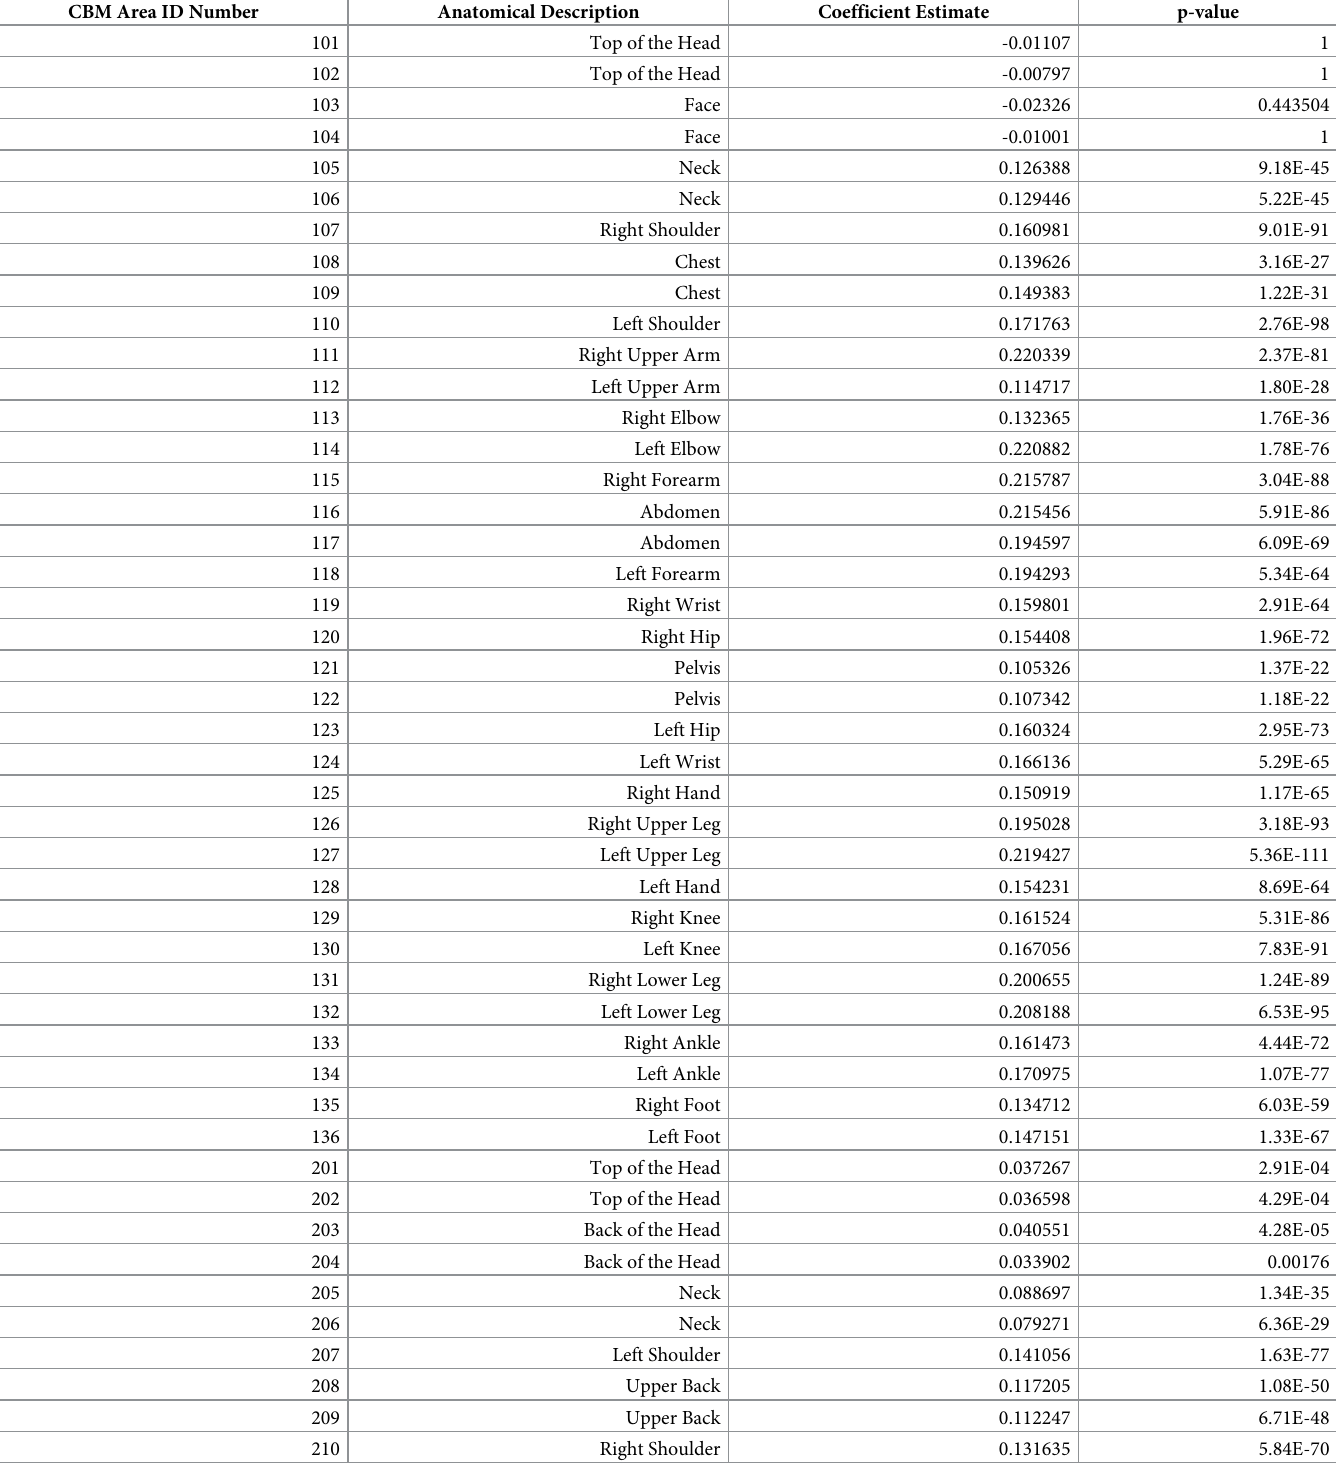
Table 2. The results of logistic regression models for each CBM location to quantify the relationship between average pain intensity score and endorsement of each location. Location codes that start with a “1” indicate the front of the body and codes that begin with a “2” indicate the back of the